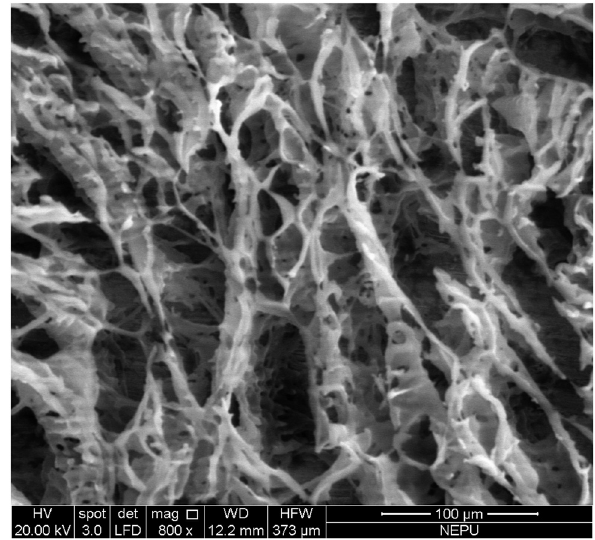
Figure 4: SEM images of the foaming agent after high - temperature treatment at 300°C for 24